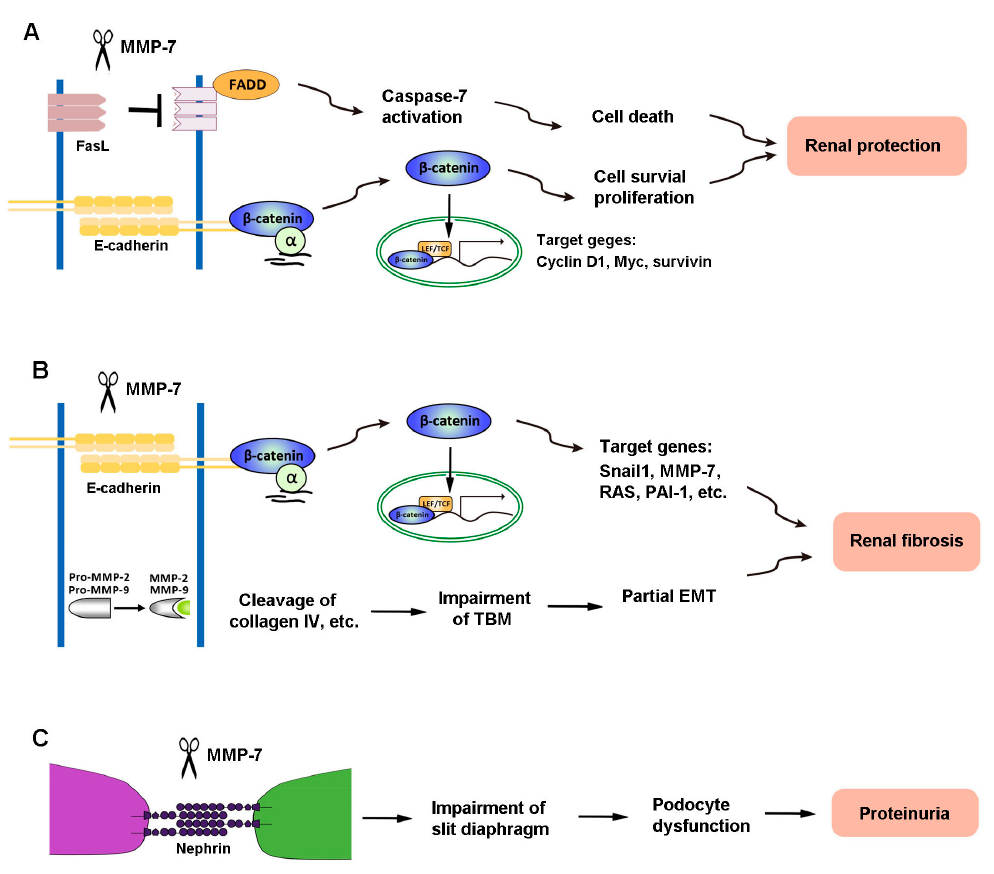
Figure 2. The mechanisms of MMP-7 action in kidney disease. ( A ) In renal tubular epithelial cells, MMP-7 promotes cell proliferation and reduces cell death by degrading E-cadherin and FasL, respectively, and finally plays a role in protecting the kidney during acute kidney injury (AKI). ( B ) However, MMP-7 also degrades E-cadherin and activates proMMP-2 and -9, leading to renal fibrosis. ( C ) In podocytes, MMP-7-mediated degradation of nephrin impairs the integrity of the slit diaphragm, which subsequently causes an increase in proteinuria and eventually leads to renal fibrosis.